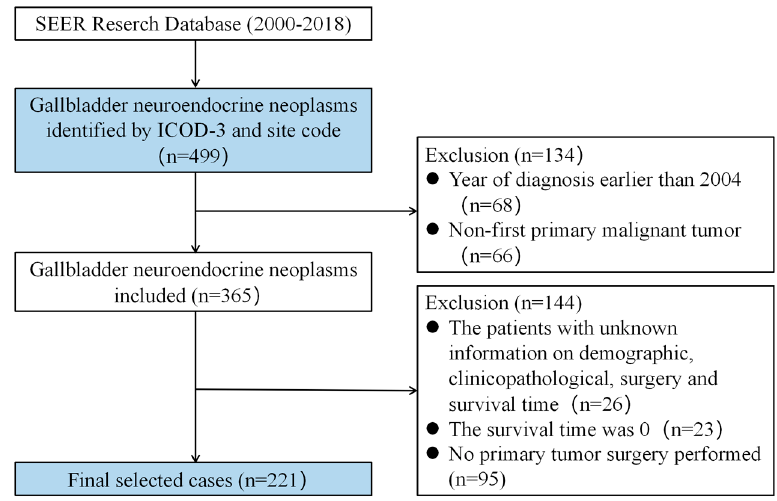
Figure 1. Flow diagram of the GB-NEN case selection procedure in the SEER database.